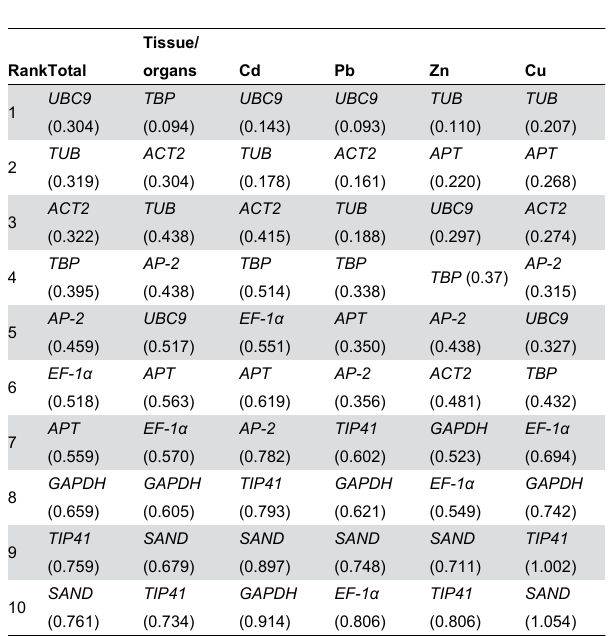
Table 2. Ranking of candidate reference genes in order of their expression stability as calculated by NormFinder.